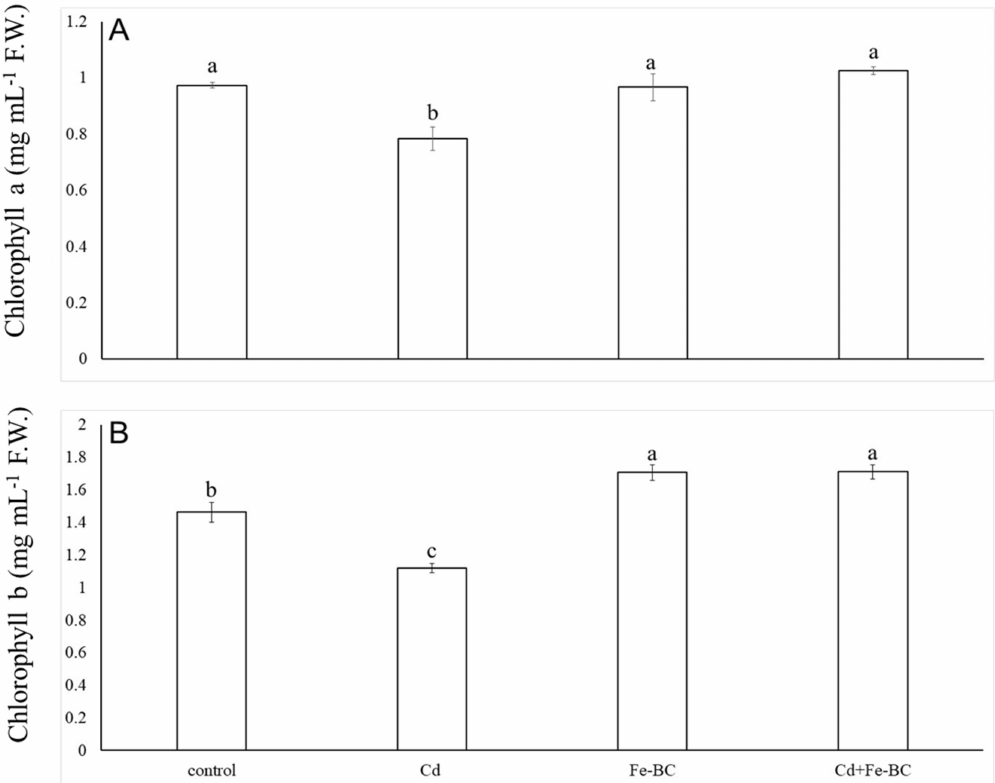
Figure 4. Chlorophyll a ( A ) and b ( B ) concentrations (mg mL − 1 F.W.) of radish cultivar grown under various treatments (control, Cd, Fe-BC, Cd+Fe-BC). There were three repeats/treatment. Values are the average of three replicates ± SEM.